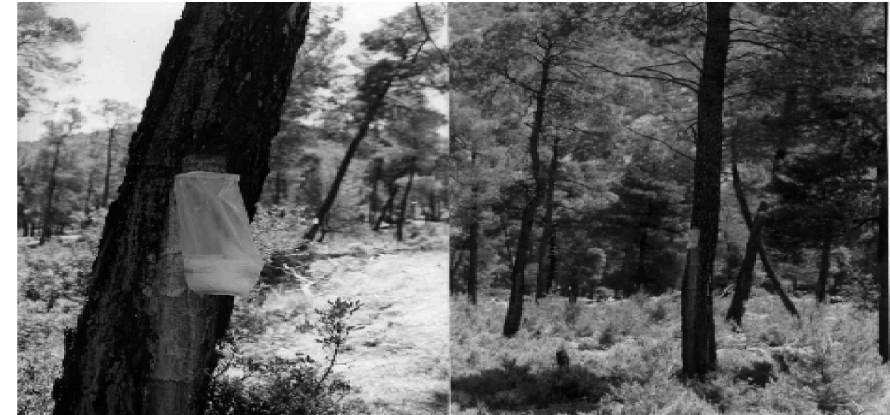
Figure 1. Resin tapping of Pinus halepensis in northern Evia, Greece.